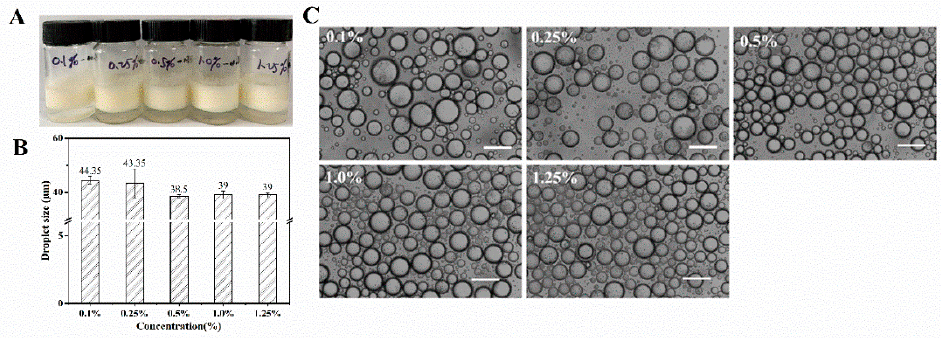
Figure 7. WPI fibrils-stabilized Pickering emulsion loaded with nobiletin at different fibrils concen- trations (0.1%–1.25%) ( A ) Appearance, ( B ) average droplet size, and ( C ) microstructure. The scale bar was 100 μ m.